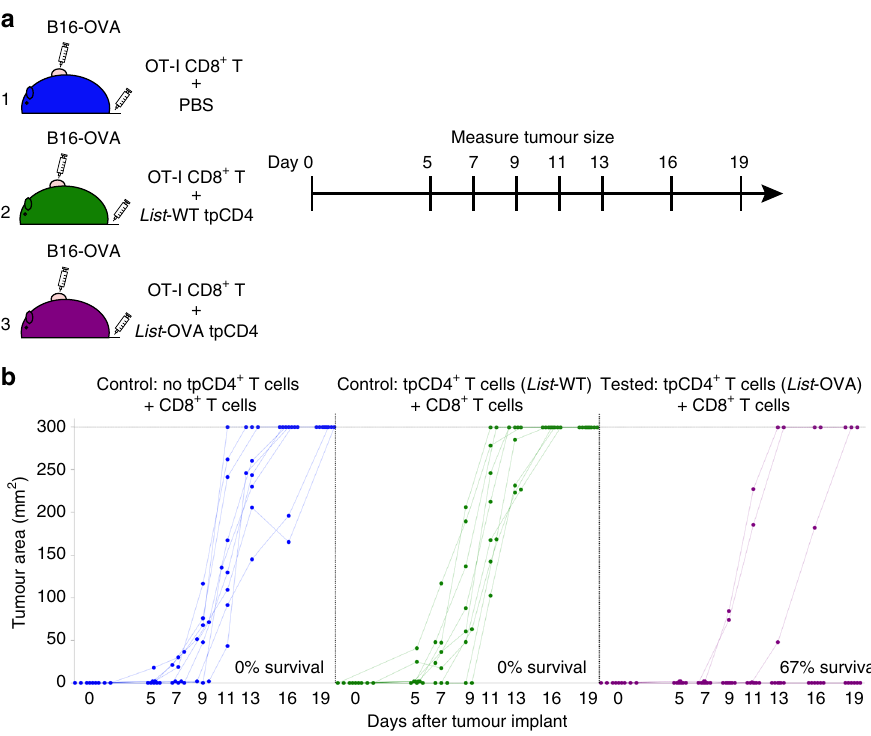
Fig. 5 tpCD4 + T cells protect from melanoma. a Scheme, and ( b ) results of the proof-of-concept experiment to test tpCD4 + T-cell ability to activate CD8 + T cells that recognize and eliminate the tumour. OVA-expressing B16 melanoma cells (5 × 10 5 ) were injected s.c. in the mid-right fl ank of recipient mice. All groups (9 mice per group) were adoptively transferred i.v. with naive CD8 + T cells from OT-I mice, together with PBS (group 1, blue), Listeria - WT tpCD4 + T cells (group 2, green) or Listeria-OVA tpCD4 + T cells (group 3, magenta). Tumours were monitored every 2 – 3 days. In b , each dot represents tumour size in one mouse measured at the indicated time. Mice with tumours ≥ 300 mm 2 were killed to avoid unnecessary suffering. The percentage of survival is